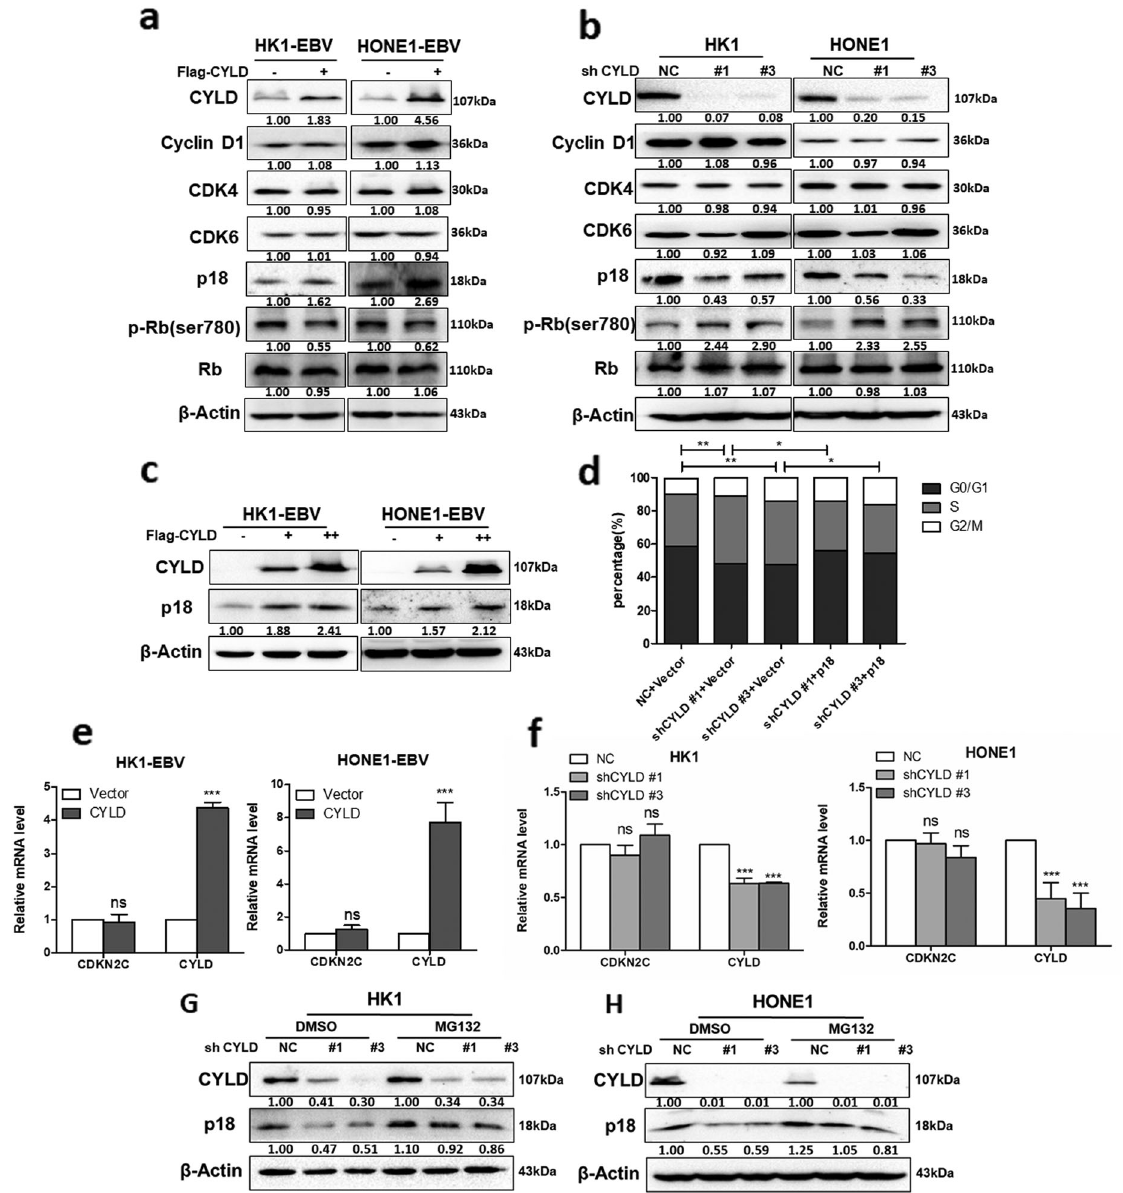
Fig. 3 CYLD regulates the protein level of p18. a HK1-EBV and HONE1-EBV cells transfected with CYLD were immunoblotted with antibodies against the indicated proteins. b HK1 and HONE1 cells were infected with CYLD lentiviral shRNAs and cell lysates were immunoblotted with antibodies against the indicated proteins. c Increasing amounts of CYLD were transfected into HK1-EBV and HONE1-EBV cells, and total protein was extracted from these cells and subjected to Western blotting using anti-CYLD, anti-p18, or anti- β -actin. d HONE1 cells were infected with the indicated lentiviral shRNAs followed by transfection with the indicated constructs, and then stained with propidium iodide and analyzed by fl ow cytometry. Total RNA either from cells infected with e CYLD or from cells transfected with the indicated f lentiviral shRNAs was isolated and subjected to qPCR. The error bars represent the S.E.M. of triplicate measurements. g HK1 and h HONE1 cells infected with the indicated lentiviral shRNAs were treated with MG132 (20 μ M) for 6 h and the indicated proteins were analyzed by Western blotting. (Data are represented as mean ± SEM ( n = 3). Differences were considered signi fi cant at * p < 0.05, ** p < 0.01, *** p <